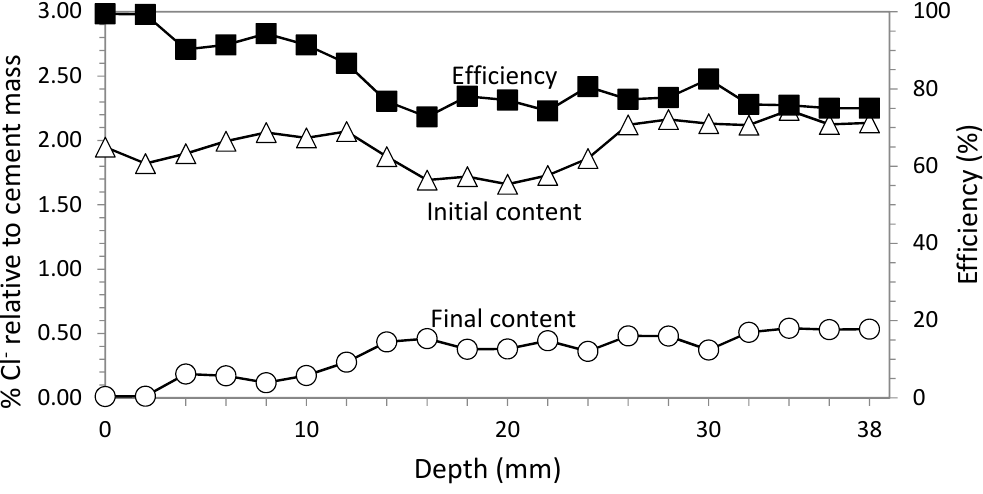
Figure 6. Study 2. Circular section specimens. ECE with GCP anodic system. Current density 5 A/m 2 . Current charge density 5 × 10 6 C/m 2 . Contents of Cl − before and after ECE and differences in percentage relative to cement mass, which conform the efficiency profile.